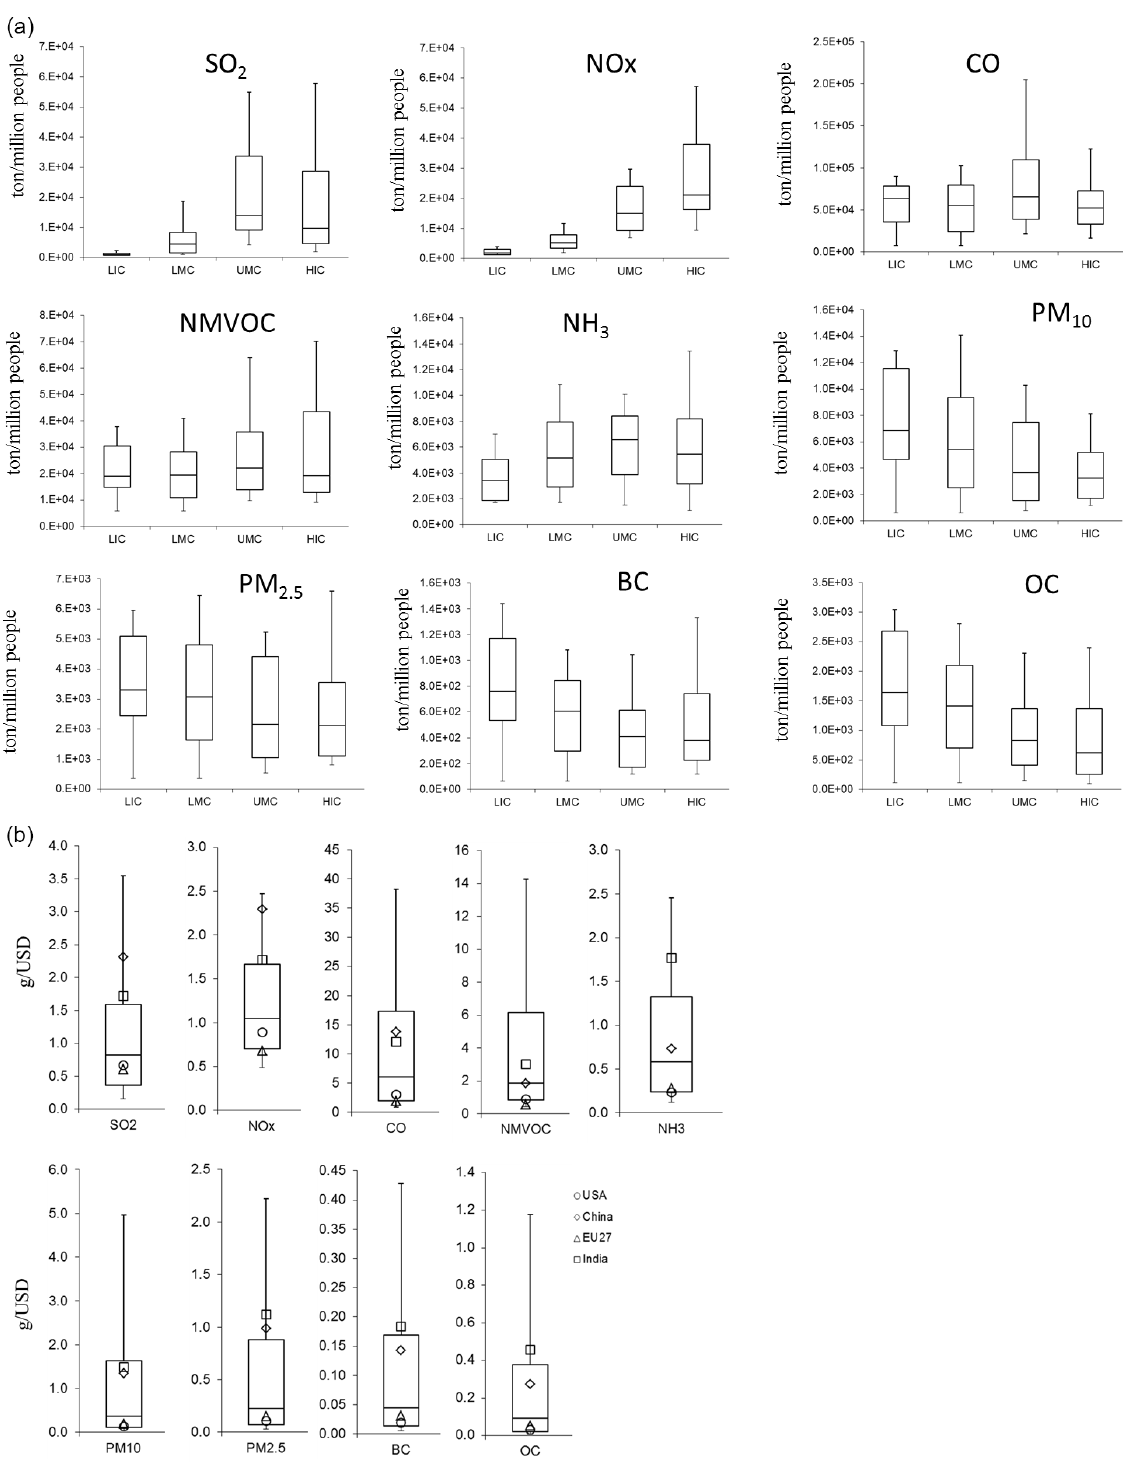
Figure 3. (a) 2010 per capita emissions per substance and per group of countries: low income (LIC), lower middle income (LMC), upper middle income (UMC) and high income (HIC) with the maximum, and minimum and the percentiles reported in the box plot (10, 50 and 90 ◦ ) and the maximum and minimum in each group of countries. (b) Pollutant specific emissions divided by GDP (gUSD − 1 ) for the year 2010. Percentiles are reported in the box plots (10, 25, 50, 75 and 90 ◦ ) together with emission/GDP for specific regions (EU27, USA, China and